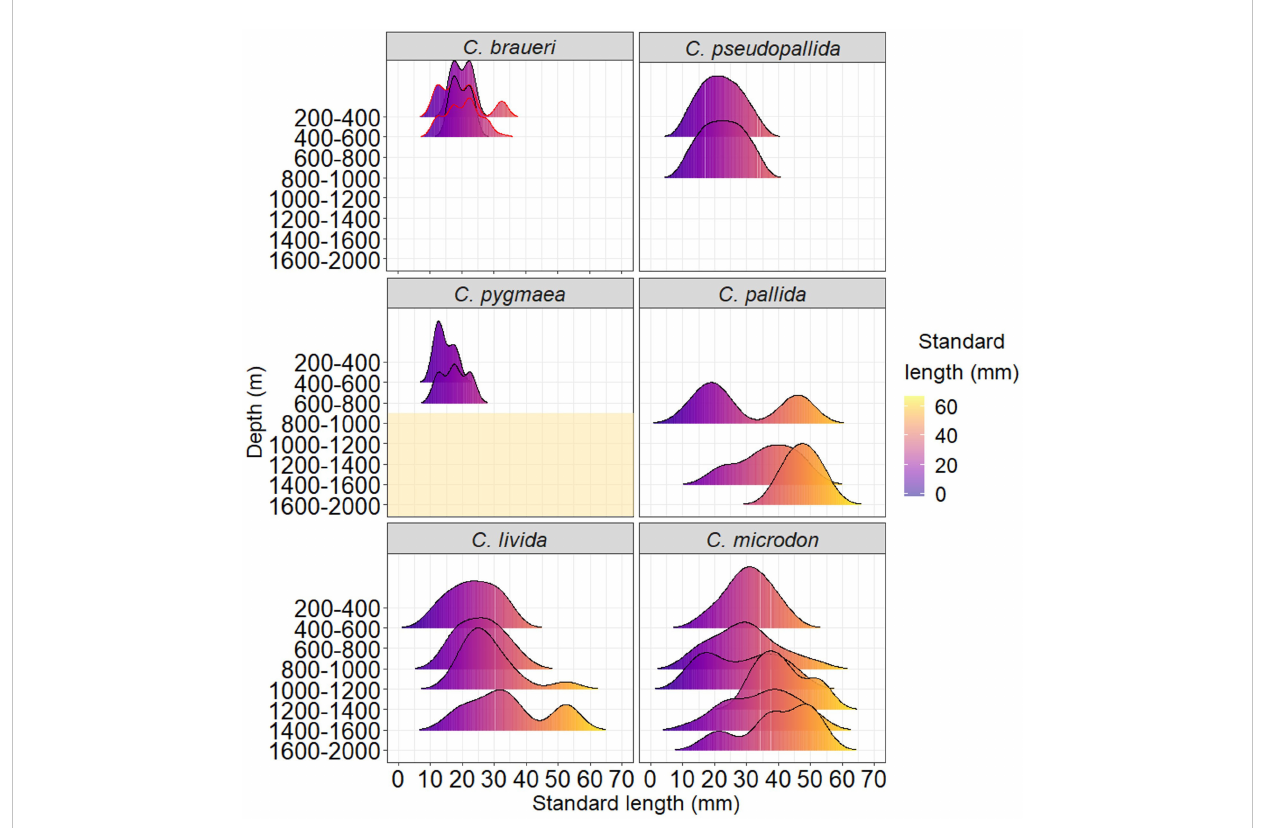
FIGURE 3 Length distribution of Cyclothone braueri , C. pseudopallida , C. pallida , C. livida , and C. microdon by size classes and depths collected with the MOCNESS-1 net (200 µm of mesh size) in the northeast Atlantic during the Bathypelagic cruise. C. braueri with a red contour and C. pygmaea data were obtained in the western Mediterranean during the SUMMER cruise. Shaded areas in C. pygmaea indicate not sampled